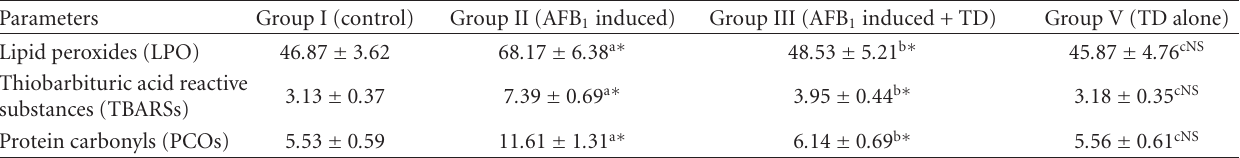
Table 2: E ff ect TD on indicators of macromolecular damage in kidney of control and experimental animals.